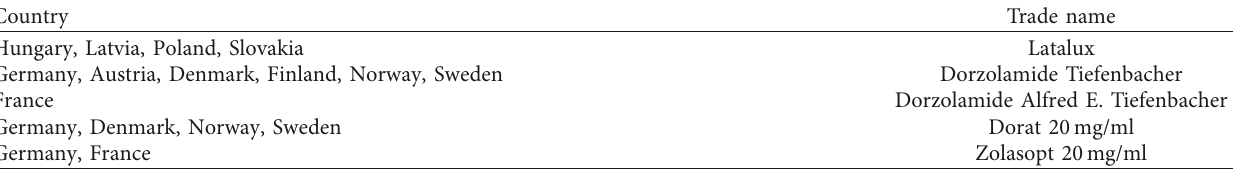
Table 5: Countries where generic dorzolamide was registered and their trade